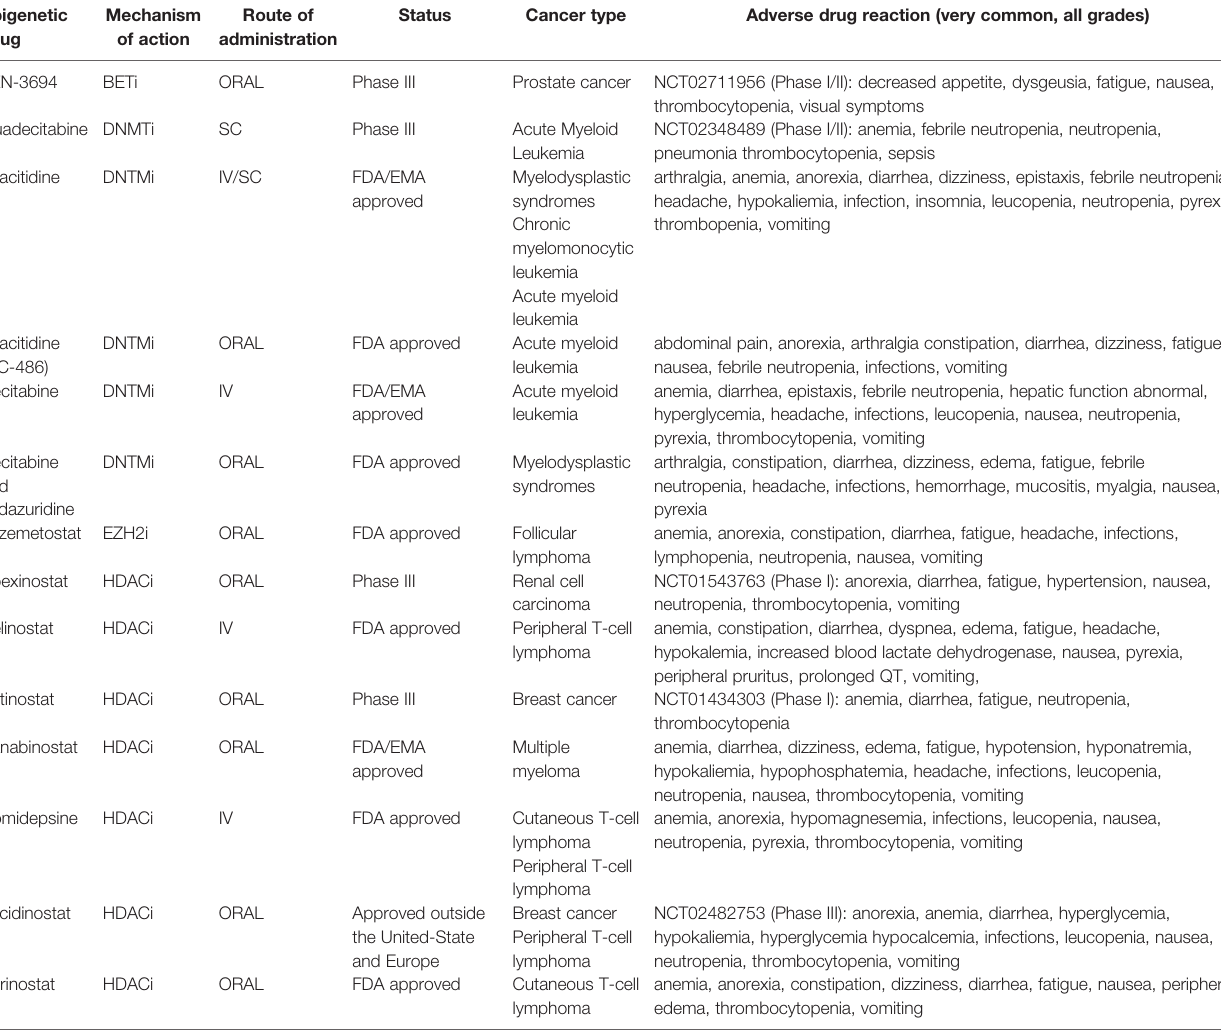
TABLE 1 | Epigenetic modulators that may in fl uence CD4 + T cells anticancer immunity. Epigenetic Mechanism Drug of